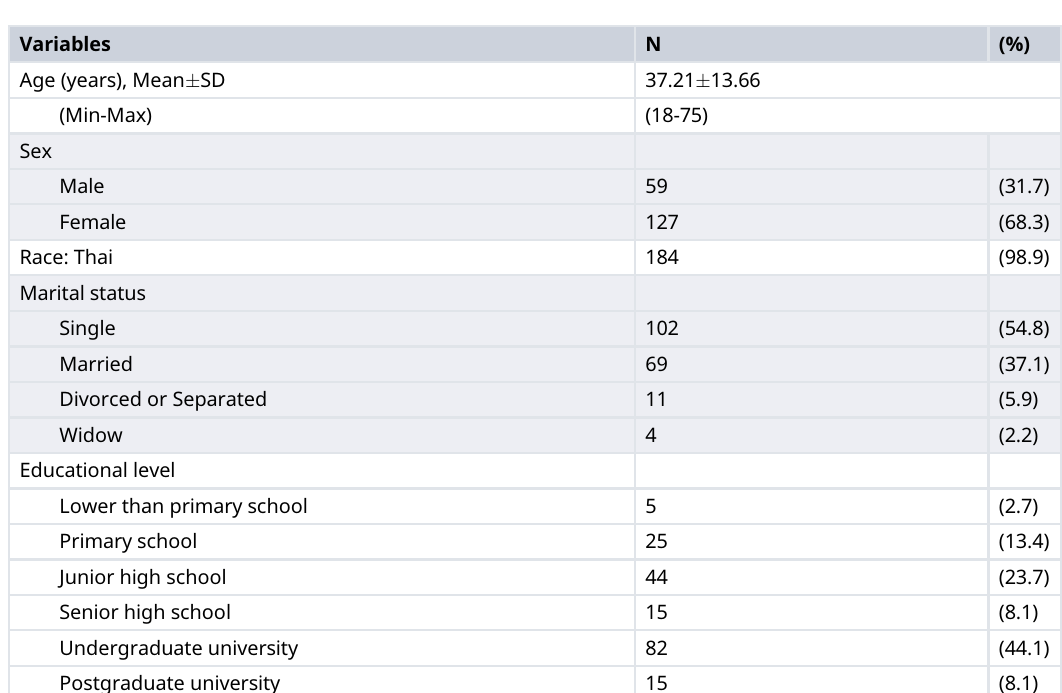
Table 1. Demographics of patients